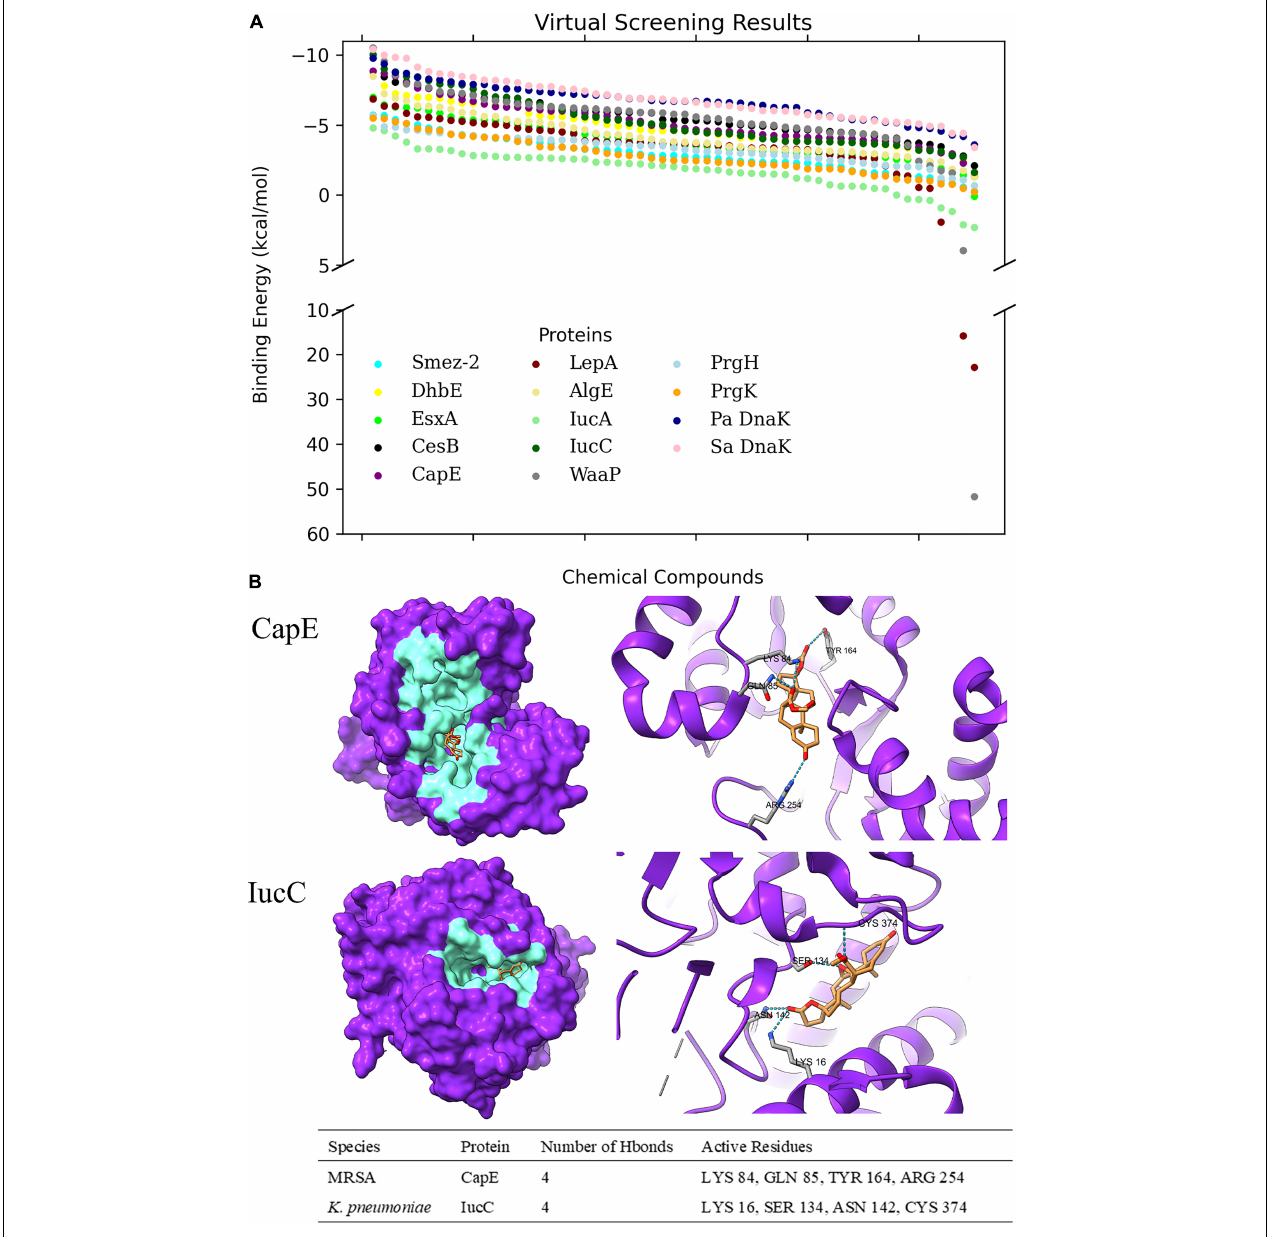
FIGURE 2 | Virtual Screening of Chemical Determinants against selected target proteins. (A) Scatter plot of virtual screening through multiple bacterial virulent proteins based on their binding energies to each chemical determinant. Pa DnaK refers to P. aeruginosa DnaK protein, while Sa DnaK refers to S. aureus DnaK protein. (B) 3D representation of Eplerenone binding to CapE of MRSA and IucC of K. pneumoniae . The localization of active residues involved in binding and hydrogen bonding interactions are shown in the table